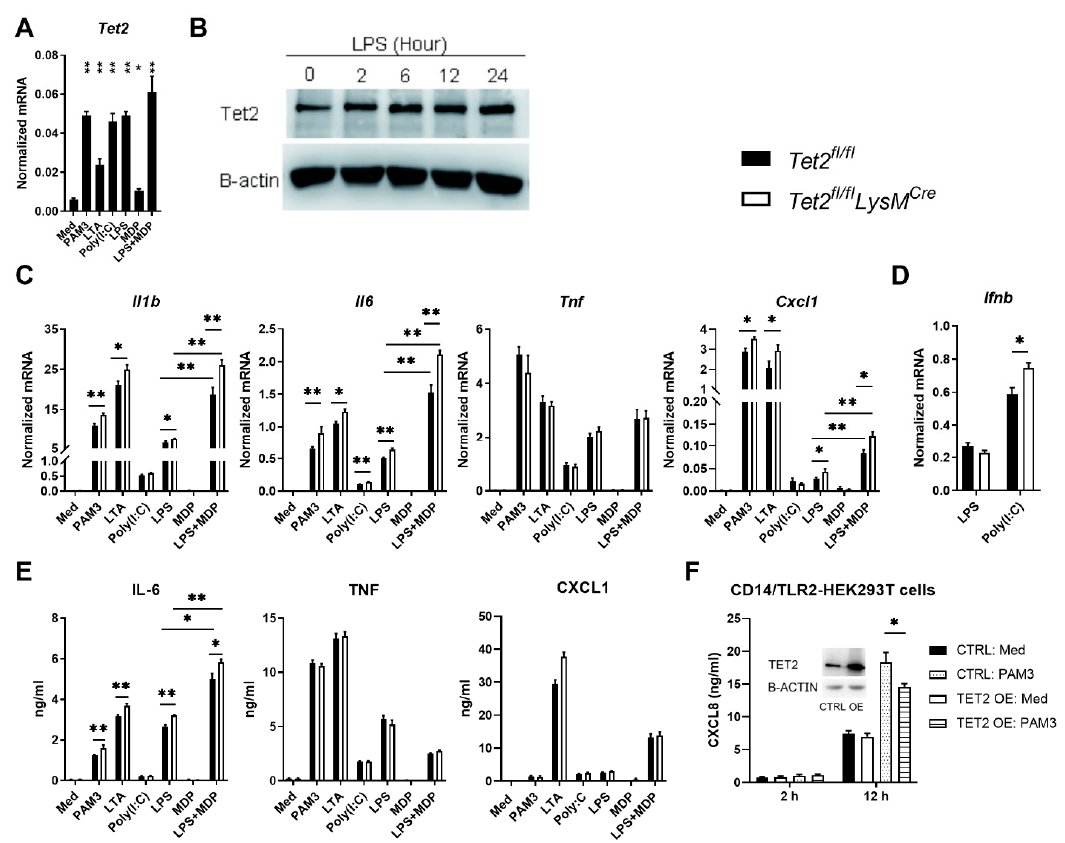
Figure 2. Tet2 represses Il1b , Il6 and Cxcl1 expression in macrophages stimulated with